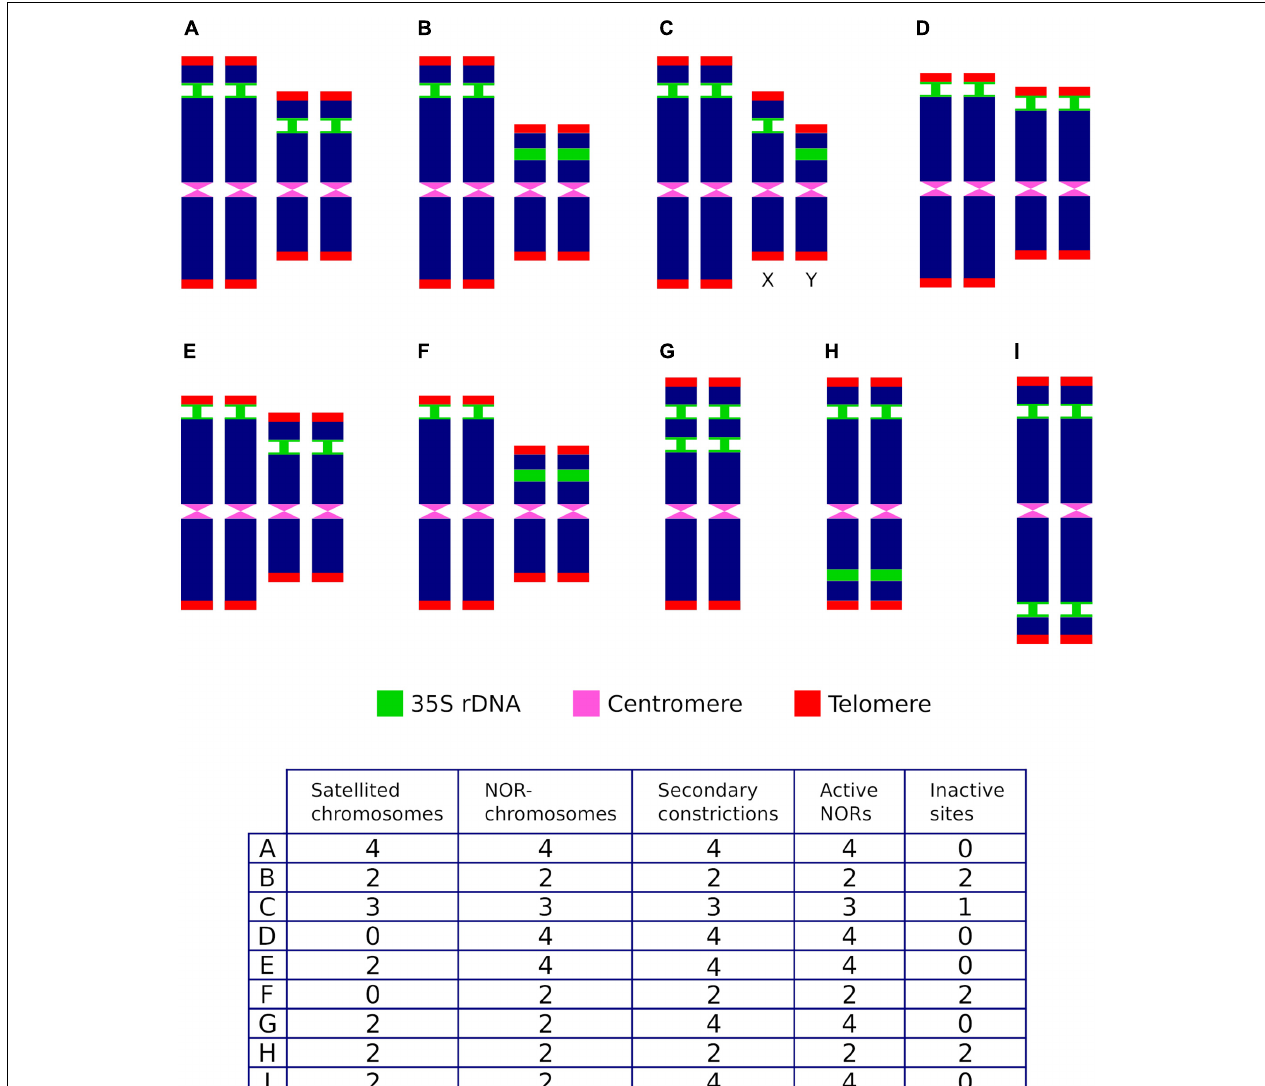
FIGURE 2 | Hypothetical ribosomal phenotypes (A–I) and their associated ribosomal descriptors for individuals showing two rDNA loci and differing in transcriptional activity, the number of chromosome pairs where they are located, the position of the loci along the chromosome arms, the presence of sites in sexual chromosomes (X,Y), the number of secondary constrictions and the presence of satellites. Active sites are represented with narrow green